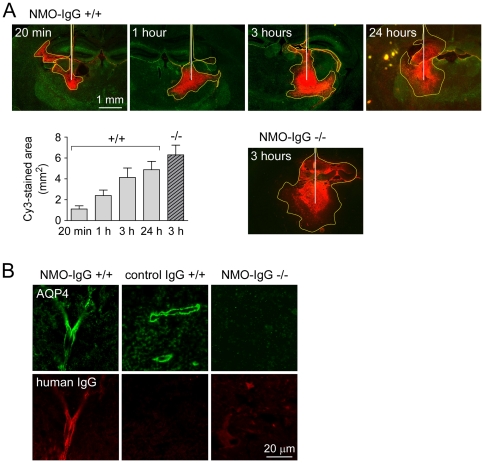
Binding and diffusion of NMO-IgG in mouse brain.A. Fluorescence micrographs showing distribution pattern of Cy3-labeled NMO-IgG at indicated times after direct injection into brain parenchyma in wild type (+/+) or AQP4 null mice (-/-). White line, needle track; yellow dashed line, area of NMO-IgG diffusion. Sections were also stained for AQP4 (green). The graph summarizes areas of Cy3 fluorescence (mm2, mean±S.E., 3 mice per group). B. Confocal fluorescence images showing colocalization of NMO-IgG (red) with AQP4 (green) in a perivascular pattern (3 h after injection).